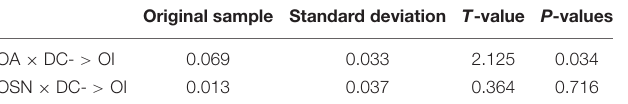
TABLE 7 | Results of the moderation effect.